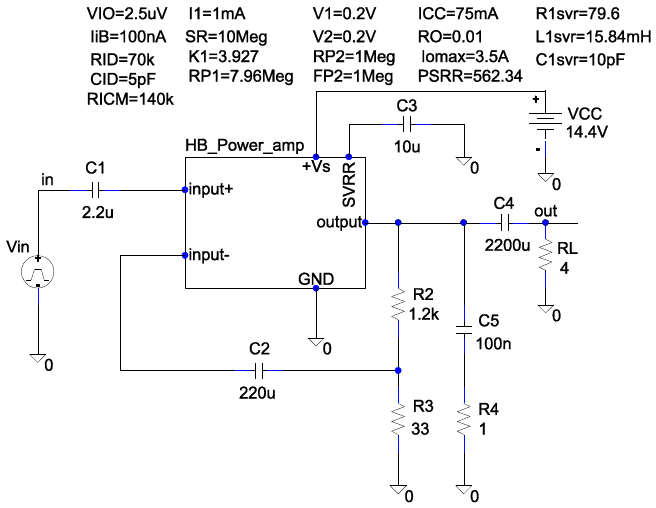
Figure 12. Test circuit for simulation of the large-signal transient response.